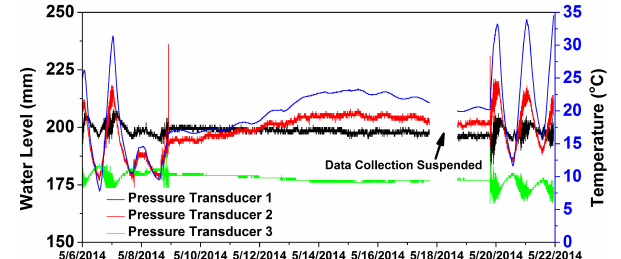
Figure 6. Time series of water level readings and water temperature in the bucket. The gap in the curves indicates the suspension of data